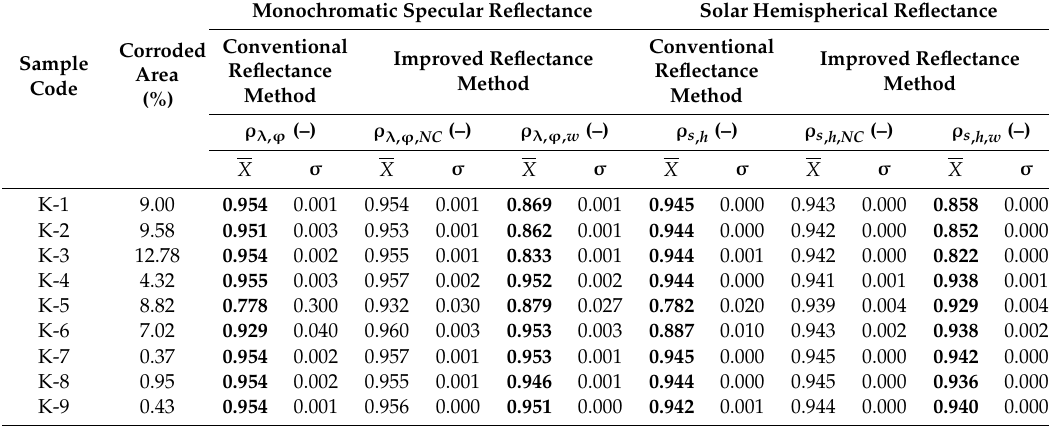
Table 4. Results of the corroded area and the monochromatic specular and solar hemispherical reflectance values for both reflectance measurement techniques, applied to the corroded samples aged in the Kerternich